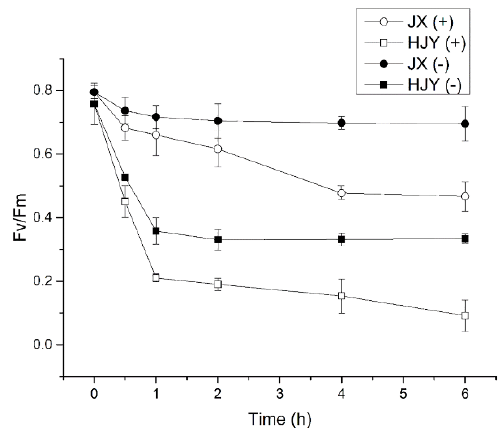
Figure 5. Effects of lincomycin on Fv/Fm in leaves of HJY and JX. Fv/Fm was measured for detached leaves (the 4th leaf beneath apex bud on bush under 30-day shading treatment) in the absence (–) or presence (+) of lincomycin during exposure to an irradiance of 1500 µ mol m − 2 s − 1 . The leaves were collected on 30th August 2018 at dusk and immersed in water before photoinhibition. Time 0 represents the dark-adapted samples before light exposure. For lincomycin treatment, the leaves were kept in darkness with the petioles in 1 mM lincomycin solution for 12 h before light exposure. The values are the mean ± standard deviation from at least six replicated experiments. HJY, cultivar “Huangjinya”; JX, cultivar “Jinxuan”.